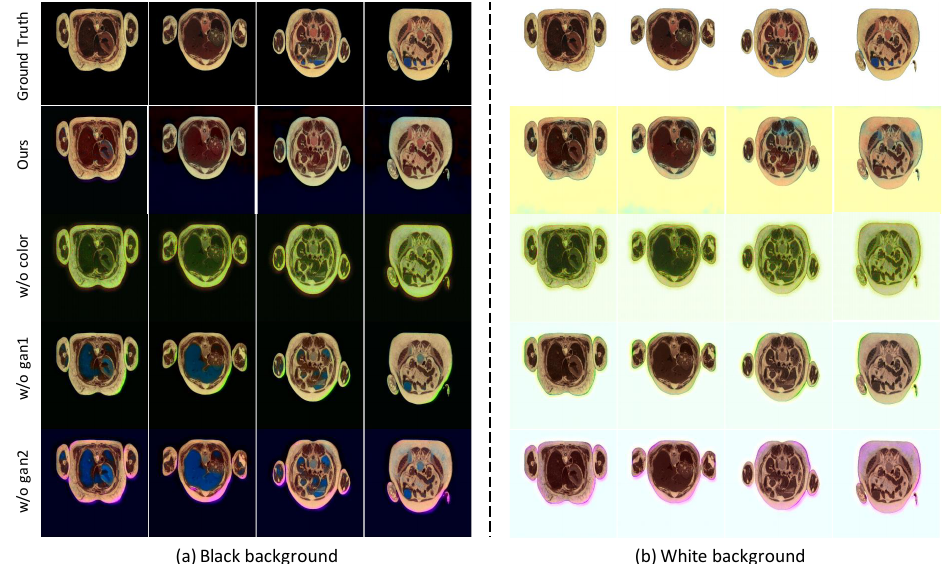
Figure 5. A comparison of colorization results under different ablation study settings. ( a ) Colorization results using images with black background as input; ( b ) Colorization results using images with white